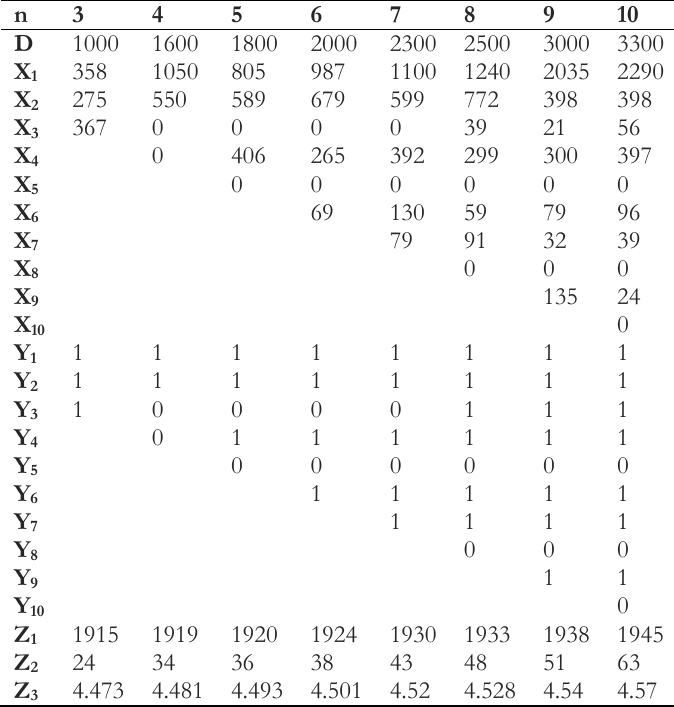
Table 5. The Results of implementation of the proposed